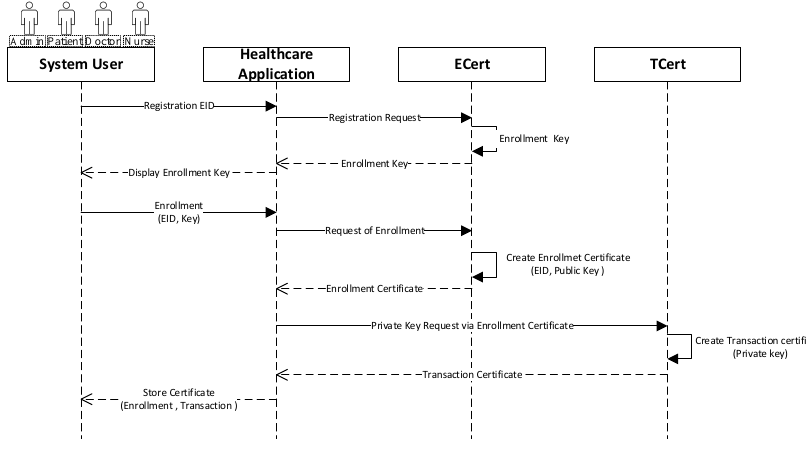
Figure 4. Identity issue for network user.